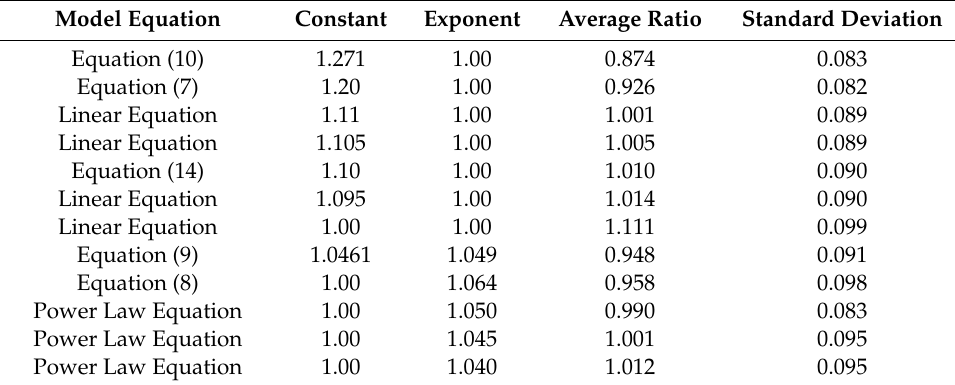
Table 1. Equation parameters and fit to experimentally observed m values.